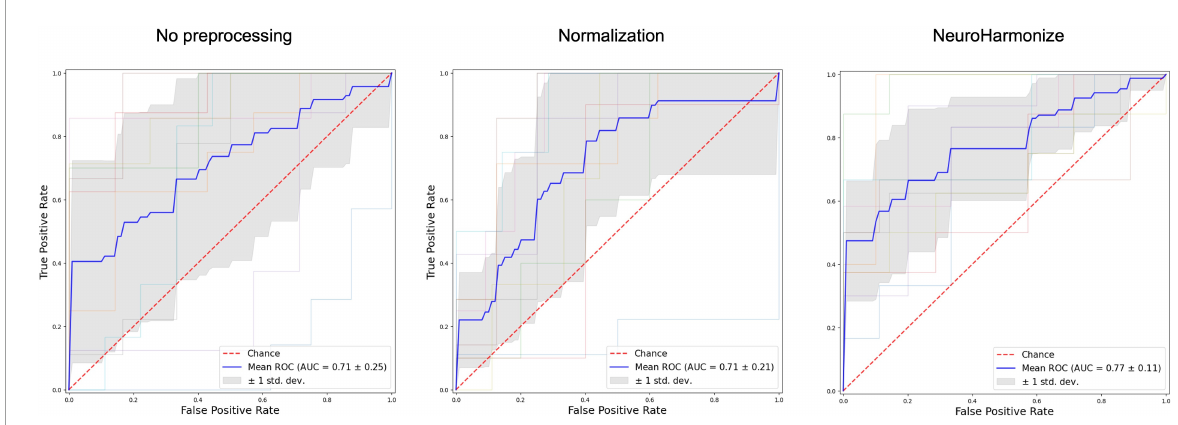
FIGURE4 Receiver operating characteristic (ROC) curves for three different radiomics features processing.